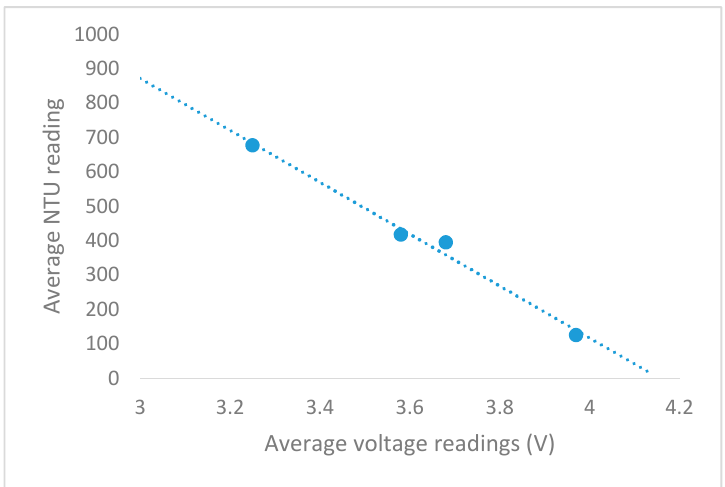
Figure 6. Relationship between turbidity and voltage.